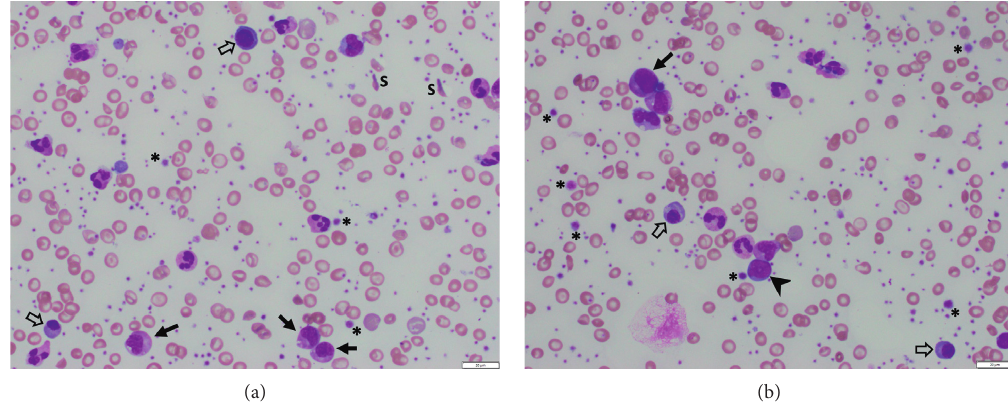
Figure 1: Peripheral blood smear (Wright–Giemsa stain, 50x magnification) showing nucleated red blood cells (open arrows), sickle cells (S), myelocytes (arrows), platelets (asterisks), and a blast (arrowhead). Numerous target cells are also